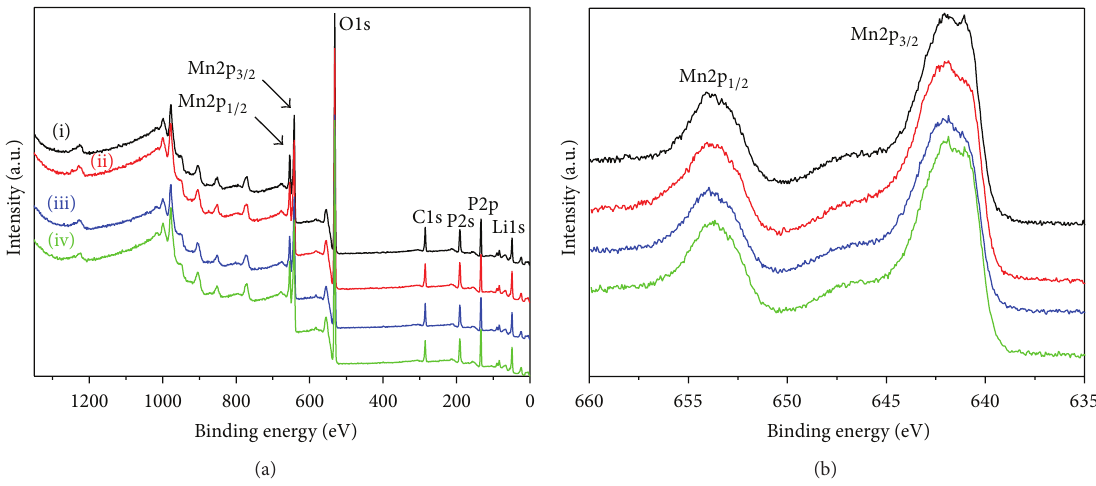
Figure 6: (a) XPS wide scan spectrum, (b) narrow scan Mn2p spectrum for LiMnPO 4 synthesized with various parameters: (i) 190 ∘ C [H 2 O]/[Mn] = 30 (sample B), (ii) 190 ∘ C [H 2 O]/[Mn] = 15 (sample E), (iii) 150 ∘ C [H 2 O]/[Mn] = 30 (sample F), and (iv) 150 ∘ C [H 2 O]/[Mn] = 15 (sample